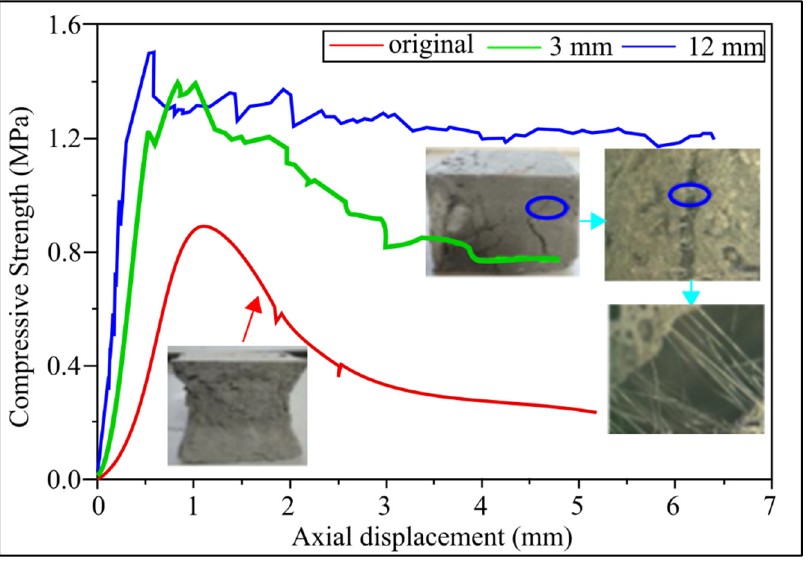
Figure 3. Effect of stress–displacement for different fibers length [27].